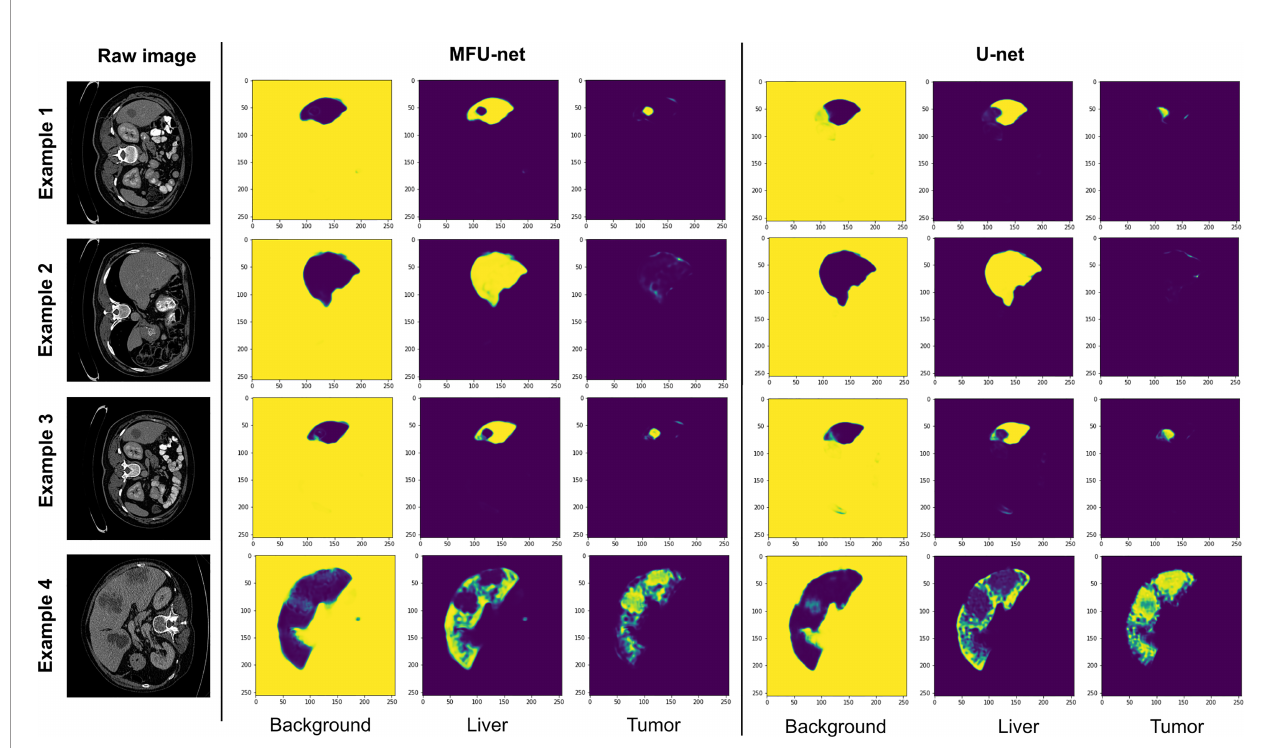
FIGURE 5 | The feature maps of the last layer extracted from MFU-net and U-net comparing with raw